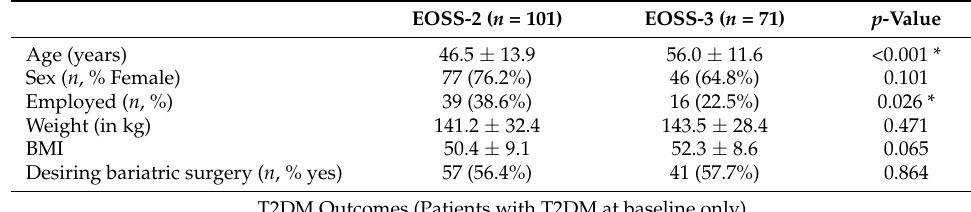
Table 2. Comparison at baseline by initial EOSS.